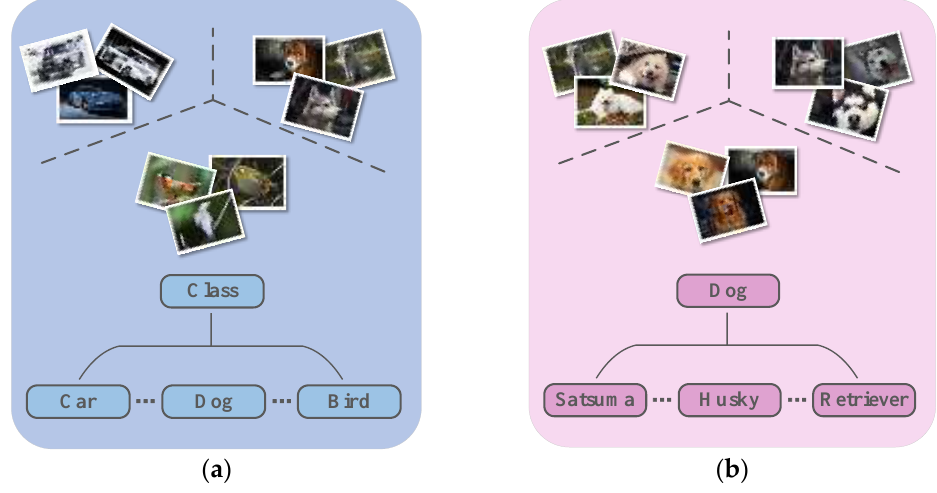
Figure 1. ( a ) Generic image recognition (coarse-grained). ( b ) Fine-grained image recognition.